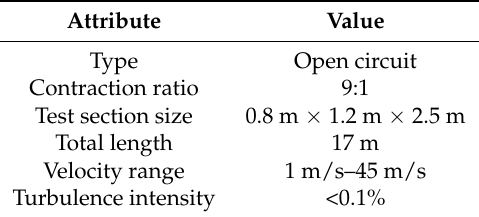
Table 3. Wind tunnel